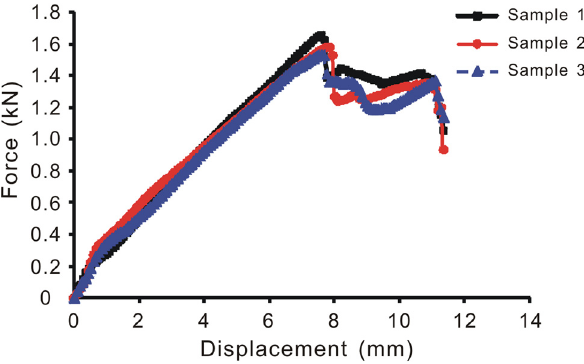
Figure 6: Force – displacement curves of specimens subjected to repeated